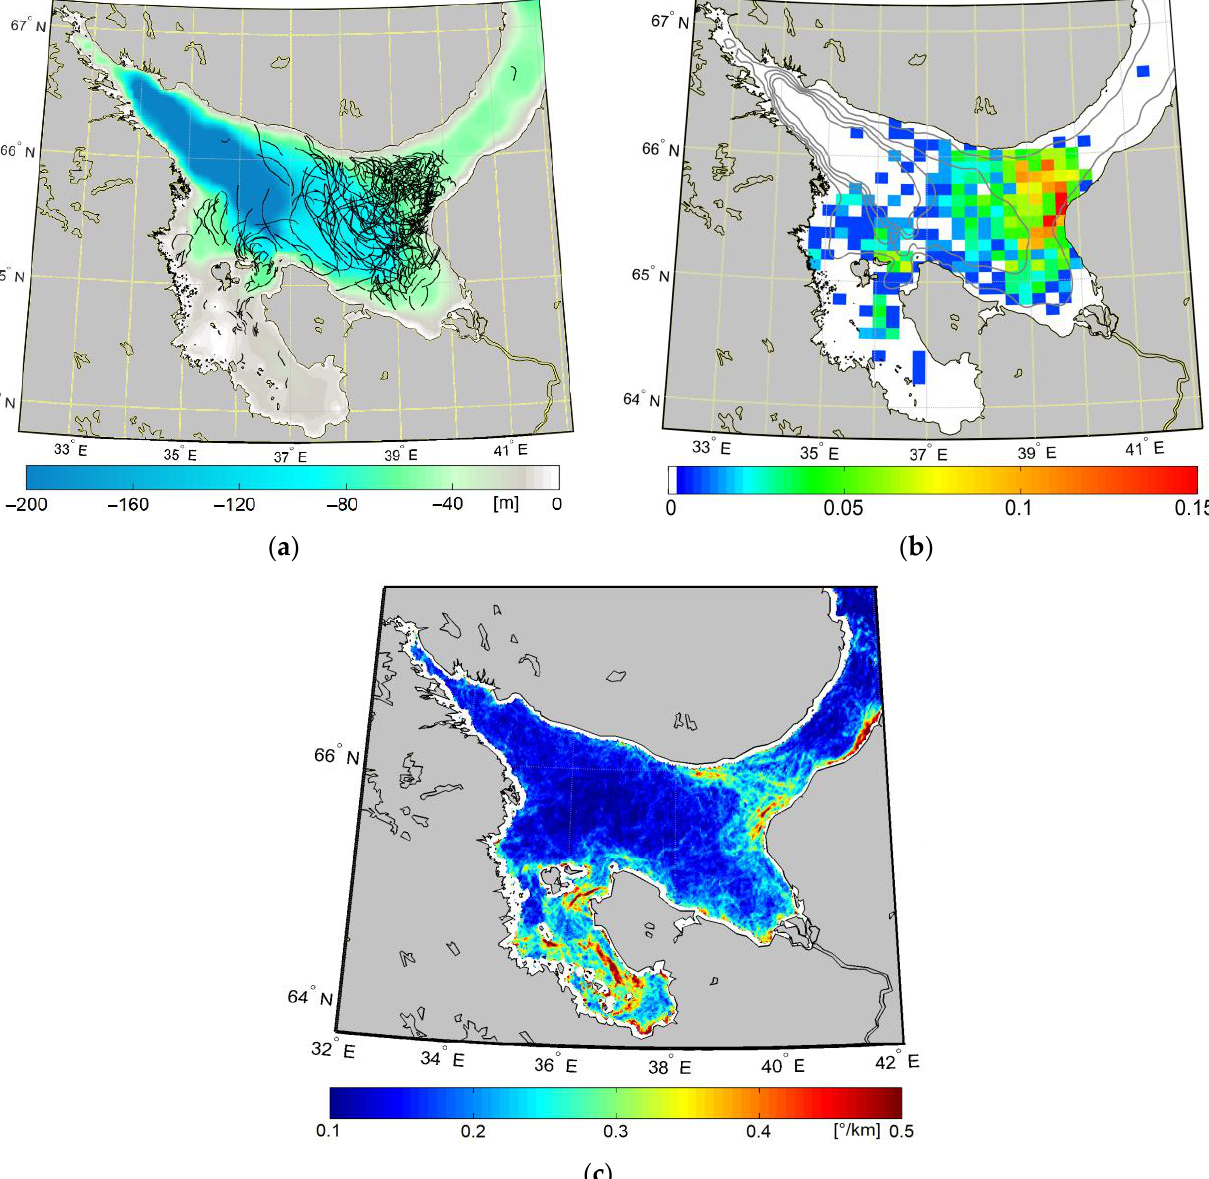
Figure 5. Summary of the ISW observations in the White Sea during 2007–2013: ( a ) Map with location of leading waves of all ISWs detected during the study period, ( b ) spatial variability of the ISW probability in the study region, ( c ) mean SST gradient calculated based on MODIS Aqua data acquired in May – September 2010.